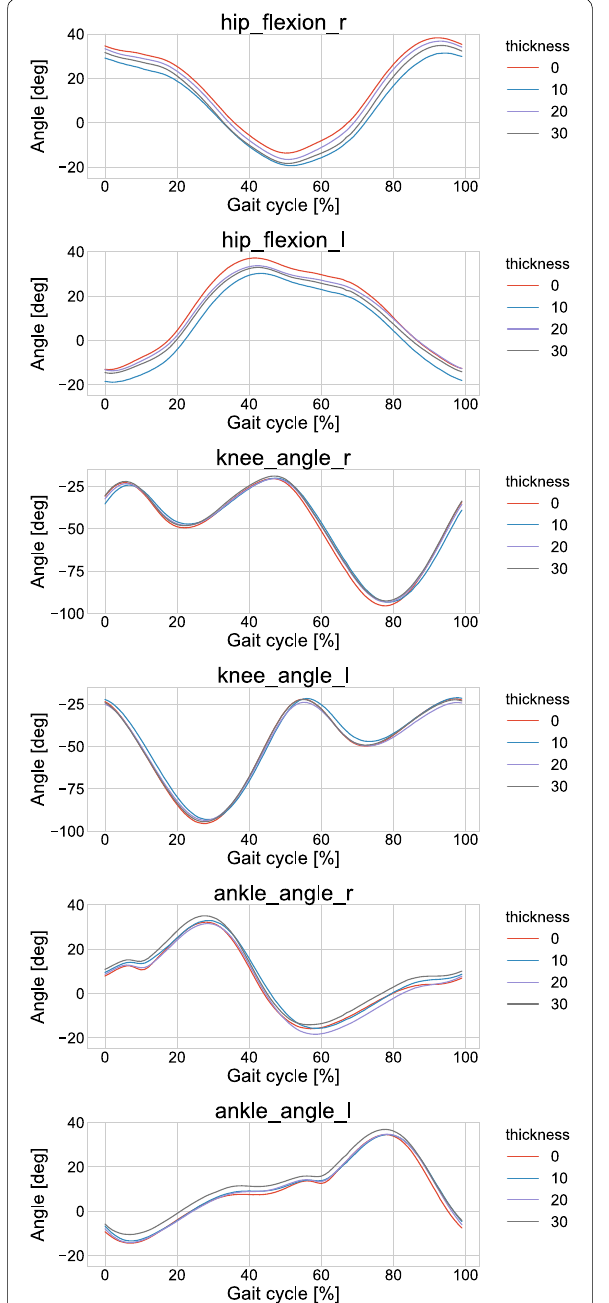
Fig. 6 Motion in the sagittal plane during running. Positive and negative hip angles represent flexion and extension, respectively. Positive and negative knee angles represent extension and flexion, respectively. Positive and negative ankle angles represent dorsiflexion and plantar flexion, respectively